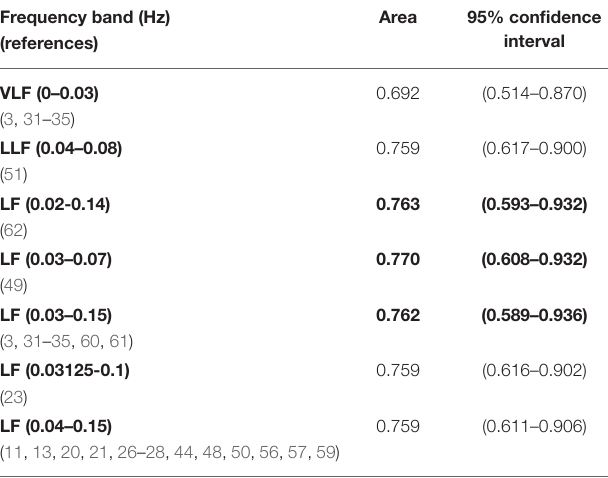
TABLE 5 | Areas under ROC curves and correspondent non-parametric confidence interval, for the bands significantly different between groups of